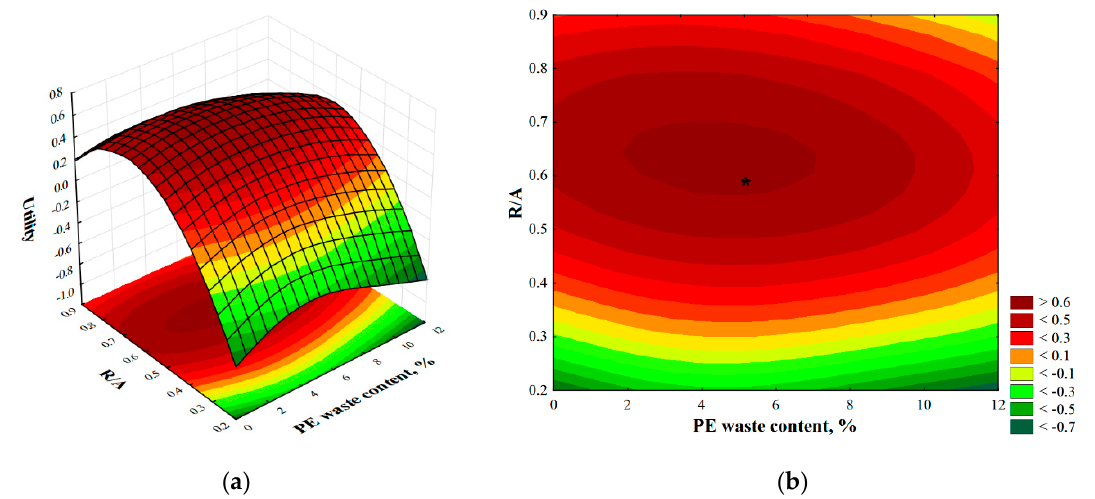
Figure 18. Three-dimensional ( a ) and contour ( b ) plot of total utility. The *-marked point in Figure 18b, indicating the centrality of the utility index in the area described by the input variables, confirms that the experimental plan was correctly defined.